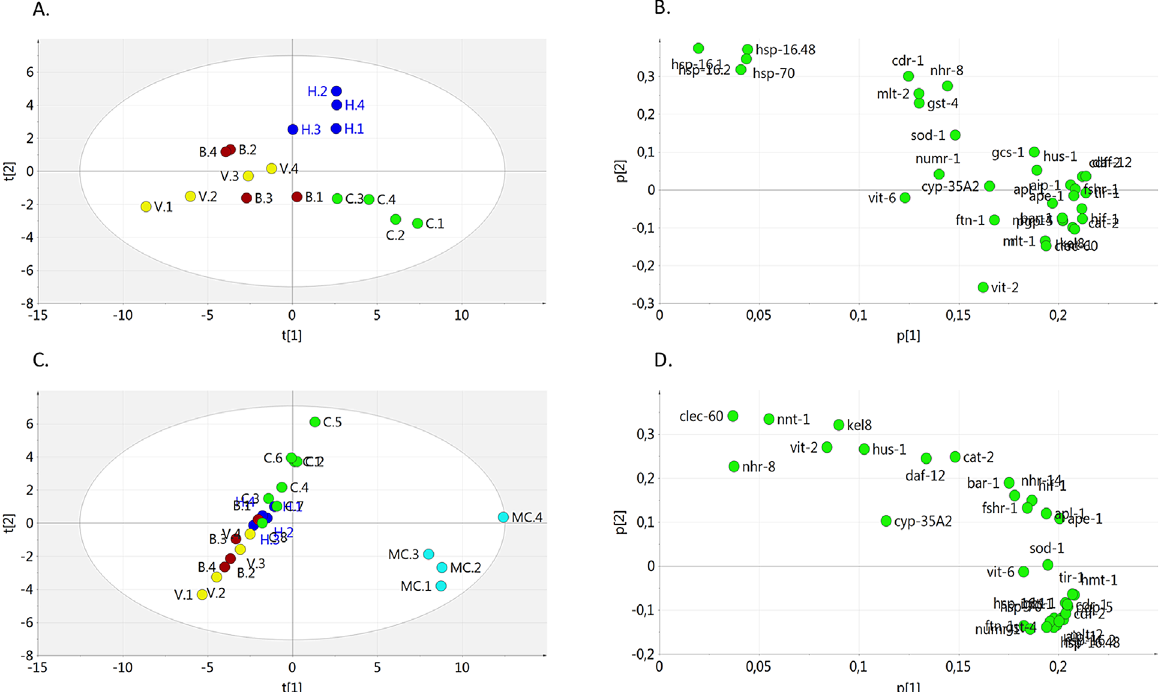
Fig 7. Principal component analysis. The PCA analysis was based on the gene expression pattern in C . elegans exposed to water samples from lake Hornträsket (H), Vormbäcken stream at Björk å s (B), Vormbäcken stream at the outlet to Vindelälven (V), K-medium prepared with Milli-Q water (C) and metal cocktail (MC). A. Score plot showing the distribution following exposure to environmental waters and control water based on gene expression. The ellipse shows Hotellings T 2 (0.05). B. PCA loading plot showing the distribution of the measured variables following exposure to the environmental waters and the K- medium control. C. Score plot showing the distribution following exposure to the MC, environmental waters and control water based on gene expression. The ellipse shows Hotellings T 2 (0.05). D. PCA loading plot shows the distribution of the measured variables following exposure to the MC, environmental waters and the control (K-medium prepared with Milli-Q